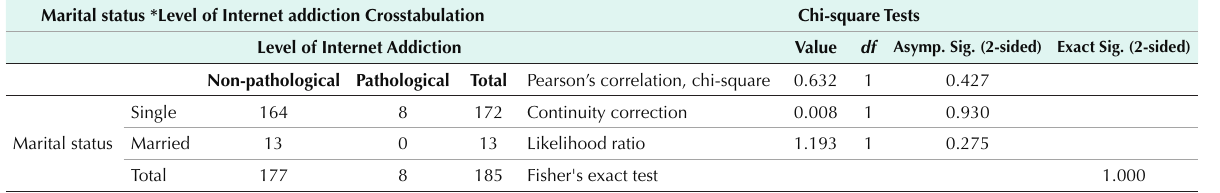
Table 3. Relationship Between Sex and the Level of Internet Addiction Marital status *Level of Internet addiction Crosstabulation Chi-square